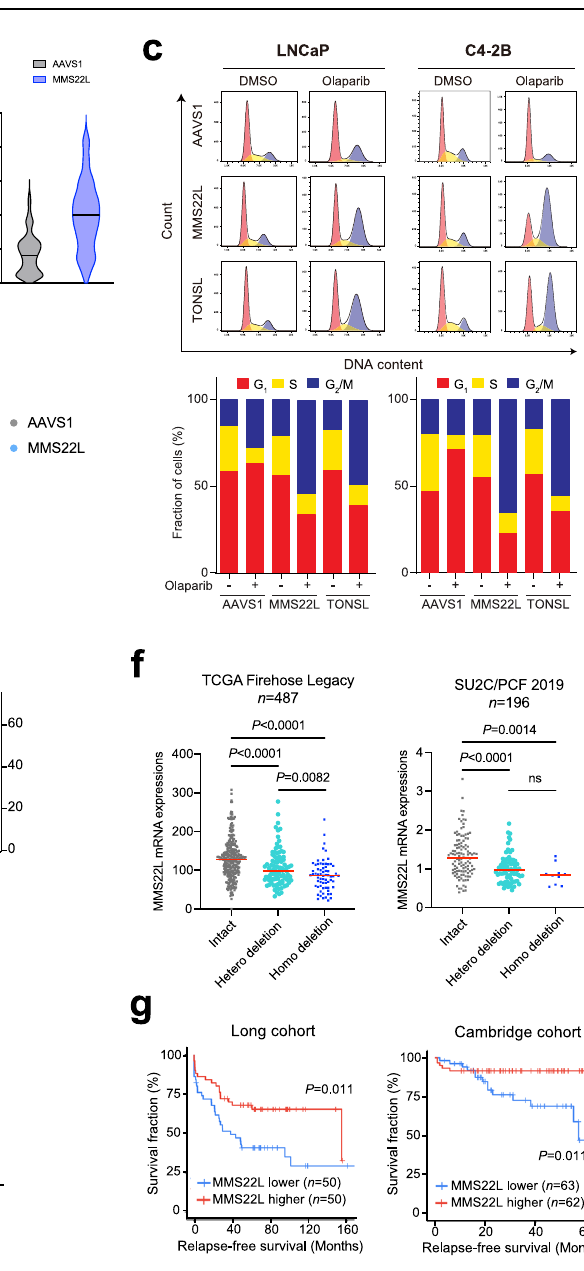
independent replicates. Scale bar=5 μ m. e Ranked HRD scores (Upper panel) in PCa tumors with BRCA and/or MMS22L genomic alterations as indicated. Compar- ison of HRD scores (lower panel) between fi ve patient groups classi fi ed based on BRCA and MMS22L status ( n =196, 48, 11, 3, and 9 tumor samples in each group, respectively). Data are presented as boxplot indicating median, 25th-75th percen- tile (box), and minimum and maximum values (whiskers). f The mRNA level of MMS22L in PCa tumors with Intact MMS22L , heterozygous (Hetero) deletion, and homozygous (Homo) deletion of MMS22L in the TCGA cohort and the SU2C/PCF cohort ( n =487 and 196 tumor samples, respectively) 25,26 . g Kaplan – Meier survival curves in the Long PCa cohort 111 ( n =50 versus 50 tumor samples) and the Cam- bridgePCacohort 112 ( n =63versus62tumorsamples)basedonthe MMS22L mRNA expression level (lower versus higher). A log-rank test was carried out to examine the survival difference. In ( b ) and ( d – f ) the p -values were determined using two- sided t -test. ns = not signi fi cant. Source data are provided as a Source Data fi le.